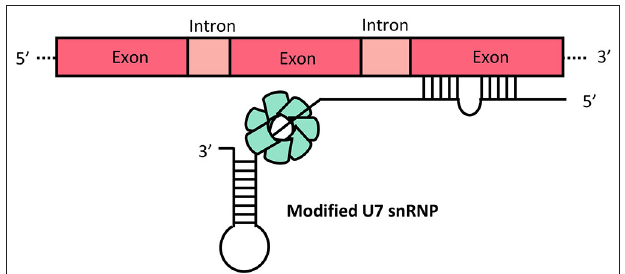
FIGURE 3 | Modified U7 snRNP. Complexes of spliceosome proteins (green) combine with U7 snRNA that is incorporated with antisense oligonucleotides targeted to the aberrant splice site of the gene. Boxes represent exons and